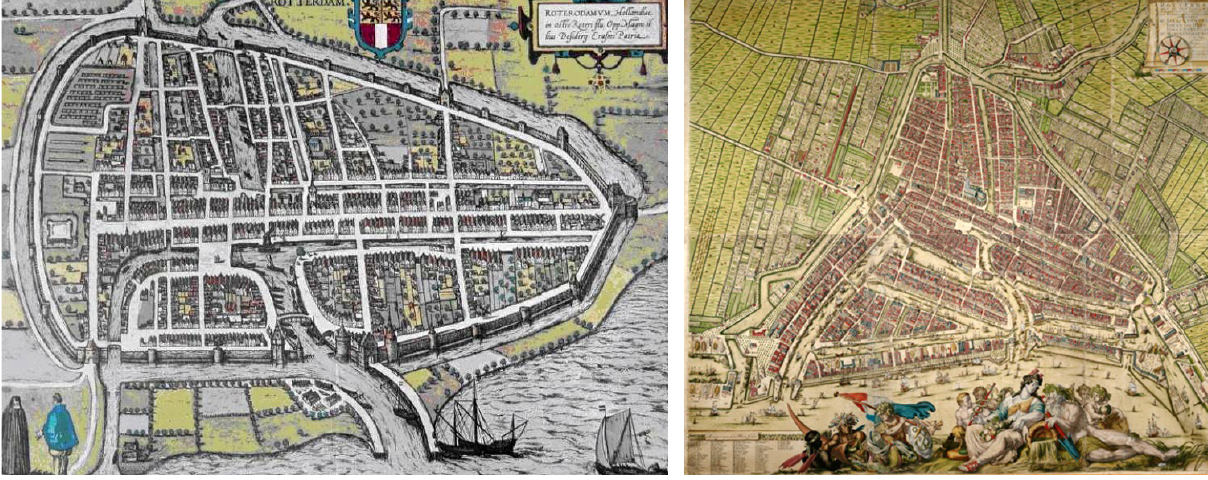
Figure 2. Rotterdam in 1588 and 1694. (a) Map of Rotterdam by F. Hogenberg, 1588 (left); (b) map of Rotterdam